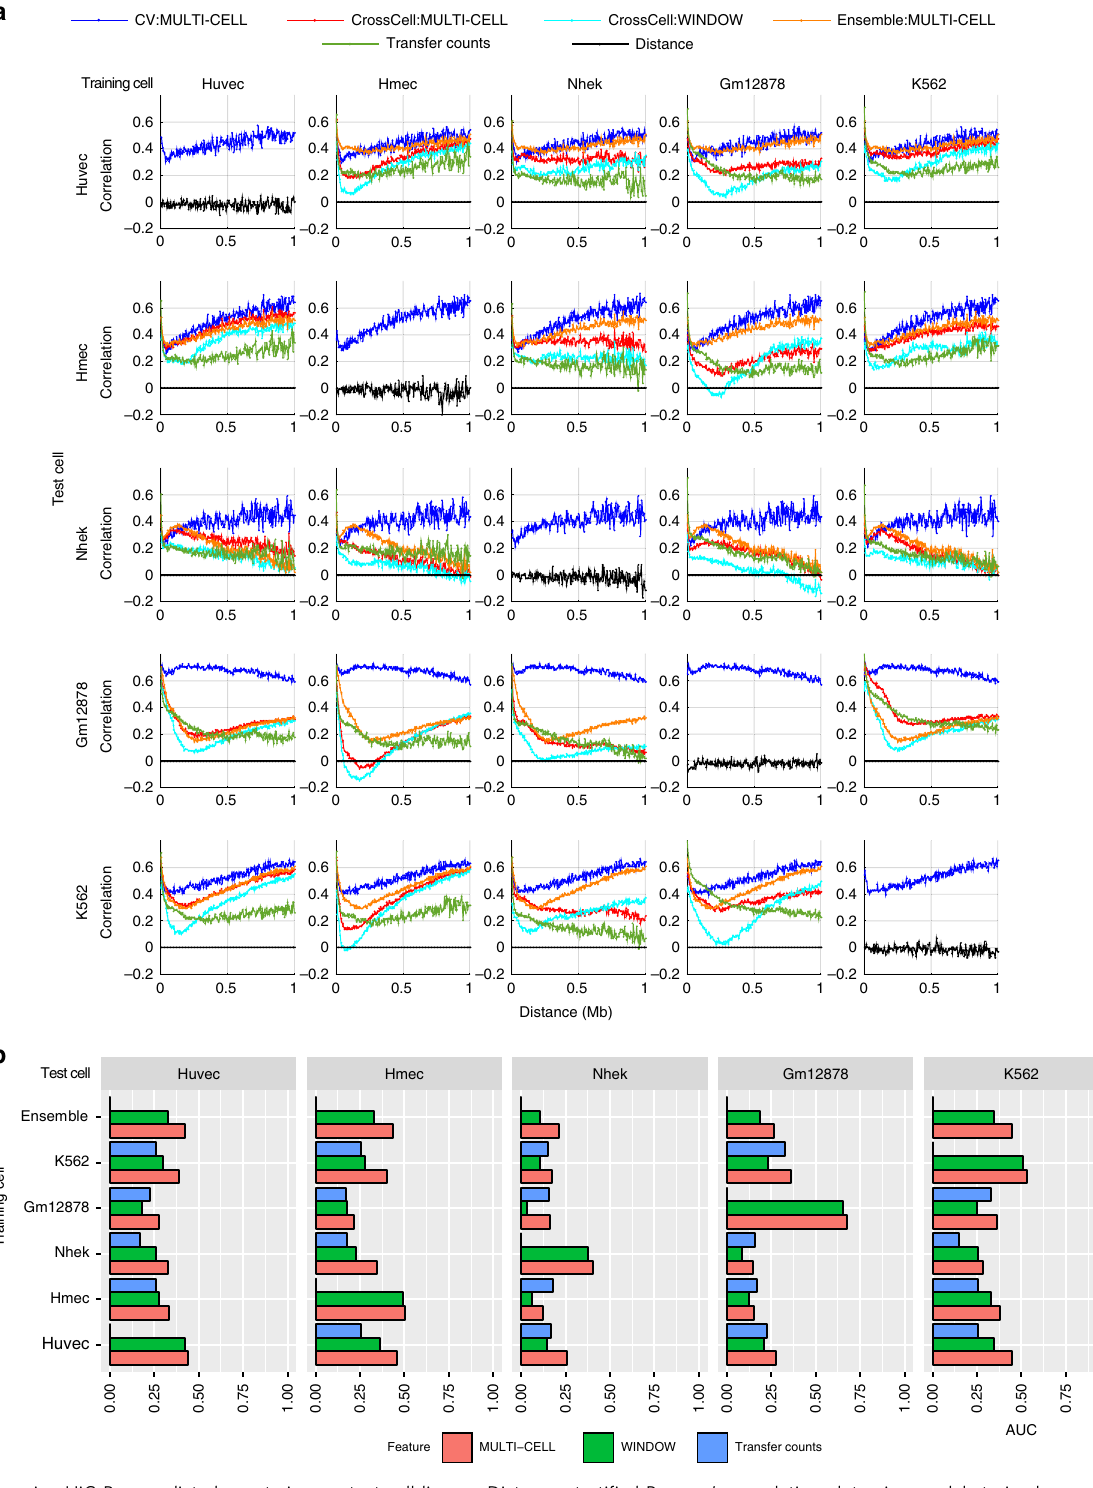
Fig. 6 Assessing HiC-Reg predicted counts in new test cell lines. a Distance-strati fi ed Pearson ’ s correlation plot using models trained on one cell line (columns) and tested on a different cell line (rows) for chromosome 17 considering all fi ve cell lines: Huvec, Hmec, Nhek, Gm12878, K562. Each plot (except the ones on the diagonal) shows the distance-strati fi ed correlation curves when training using the same cell line (blue), a different cell line using MULTI-CELL (red) and WINDOW (cyan) features, using the ensemble of all predictions from a different cell line (orange), and when simply transferring counts (green). The plots on the diagonal show the CV performance. b Area under the curve (AUC) for distance-strati fi ed correlation in chromosome 17. Shown are the AUCs for the different training cell line models for both feature types (red and green), ensembles from both feature types, as well as transfer count when predicting in a new cell line. Source data are provided as a Source Data fi